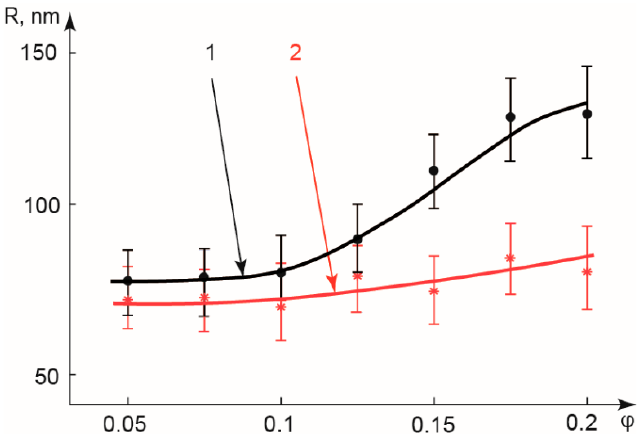
Figure 6. Hydrodynamic radii of PDADMAC-SDS complexes synthesized in microfluidic droplets at various flowrate ratios φ : 1—linear main channel; 2—serpentine main channel. Ca ≈ 0.005.